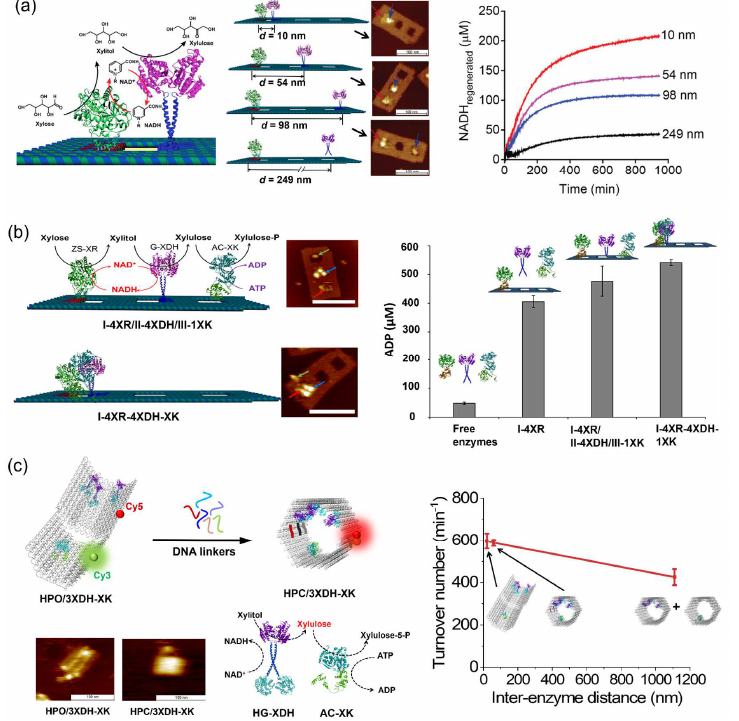
Figure 12. Enzyme cascade reactions derived from the D-xylose metabolic pathway studied on the 2D or 3D DNA scaffold. ( a ) Enzyme cascade reactions of xylose reductase/xylitol dehydrogenase (XR/XDH) on the DNA scaffold. By changing the enzyme locations of XR and XDH, the interen- zyme distance was regulated [80]. ( b ) Xylose reductase/xylitol dehydrogenase/xylulose kinase (XR/XDH/XK) cascade reactions on the DNA scaffold. The ADP production used a measure of the cascade reaction efficiency [81]. ( c ) Enzyme cascade reactions of XDH and XK assembled on a 3D DNA hexagonal prim (HP) with the dynamic shape transformation. The dynamic transition from the open state of HP (HPO) to the closed state (HPC) was induced by the addition of DNA linkers that hybridized with the two domains of HP [102]. Reprinted with permission from: ( a ) Ref.